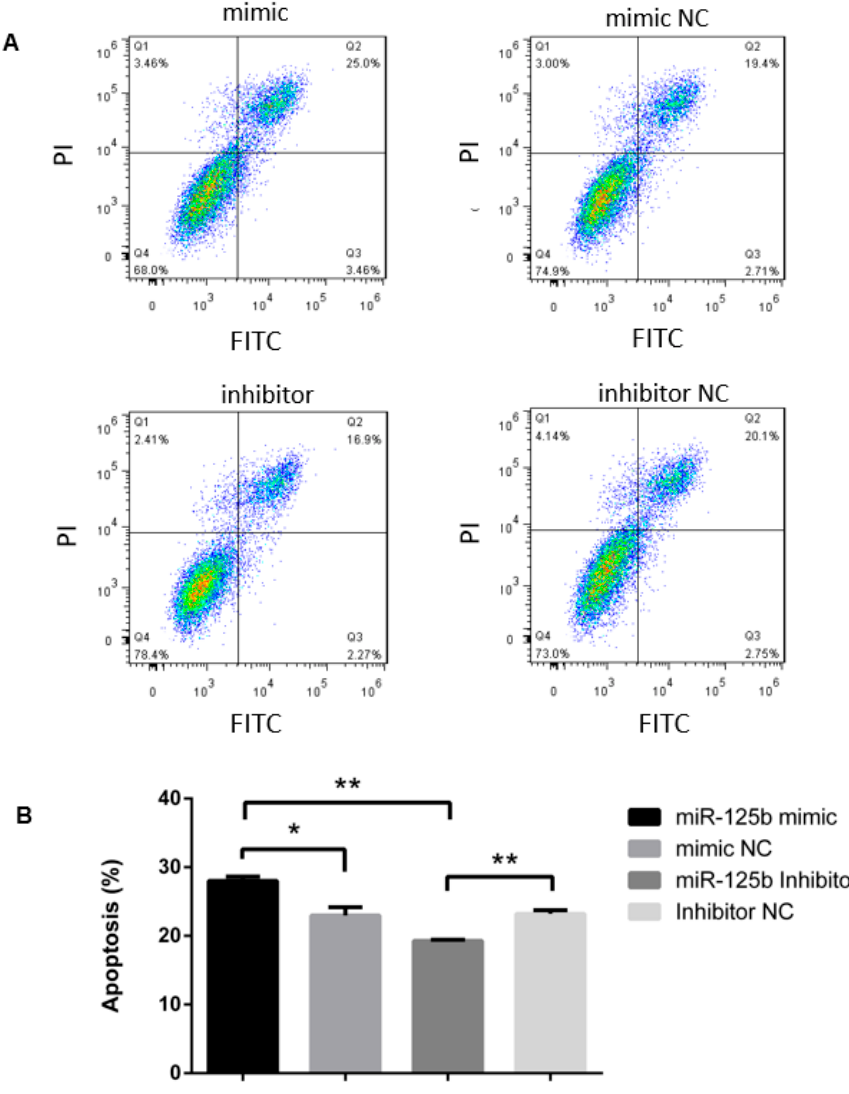
Figure 1. miR-125b is positively related to the apoptosis rate. ( A ) The effect of miR-125b on HP45 cell apoptosis was analyzed by flow cytometry. A miR-125b mimic or mimic negative control (NC; 50 nM) and a miR-125b inhibitor (100 nM) or NC were transfected into HP45 cells in 6-wells plate. Q1 represents cell death; Q2 represents late-stage apoptotic cells; Q3 represents early apoptotic cells; Q4 represents normal cells. ( B ) The flow cytometry results were analyzed by prism software to quantified the effect of miR-125b on apoptosis. Data are provided as the means ± standard deviation for triplicate measurements from a representative experiment. * P < 0.05; ** P < 0.01.